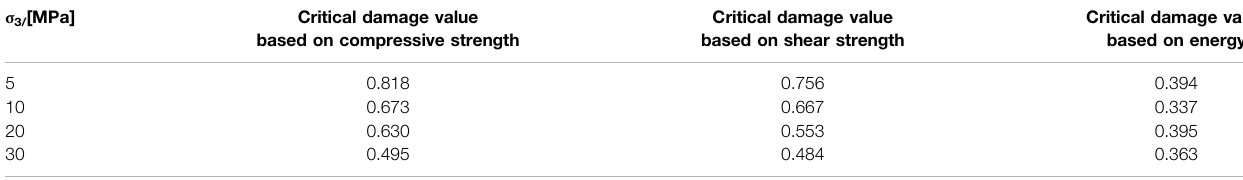
TABLE 3 | Table of critical damage values based on different physical quantities for different con fi ning pressures.